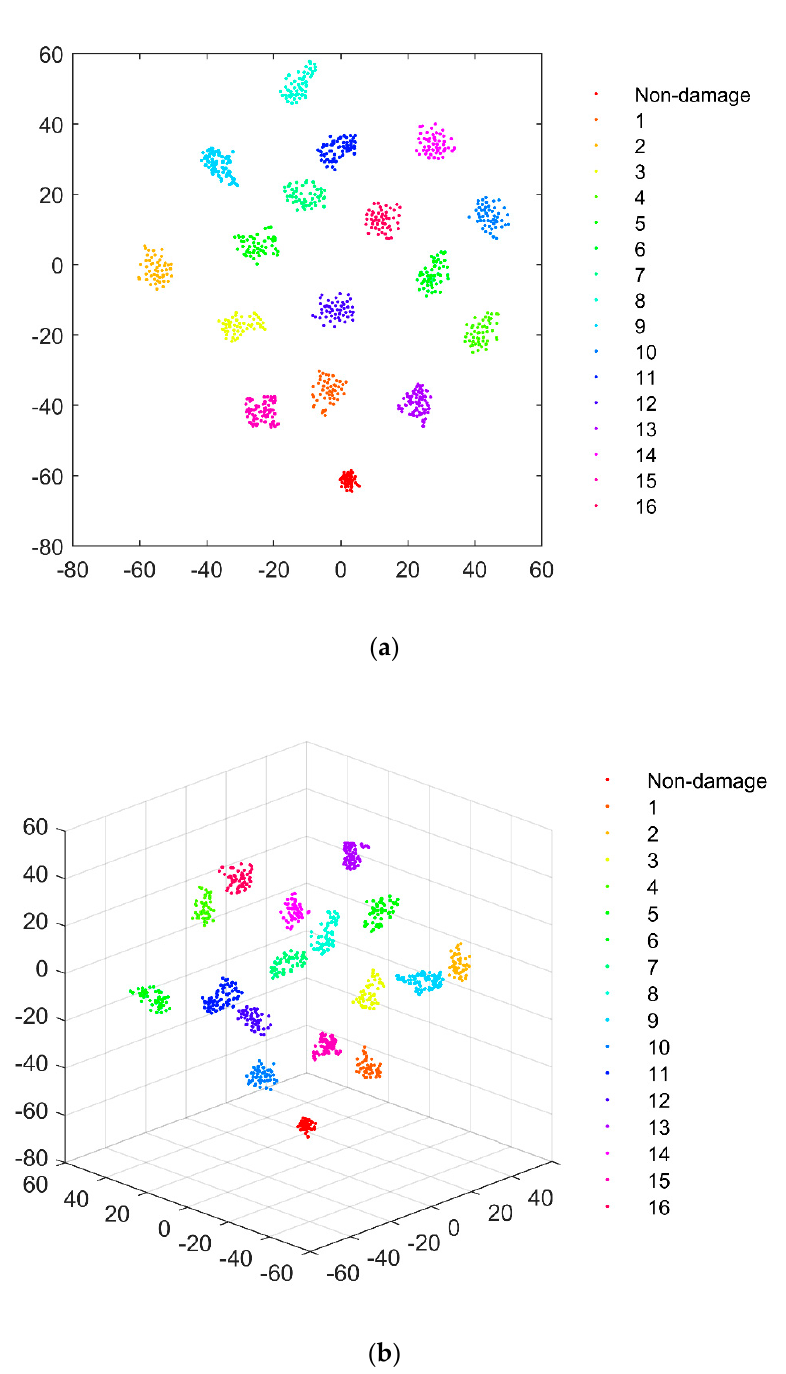
Figure 10. Visualization results of the damage features in the TF signals extracted by the 1D CNN model: ( a ) two- and ( b ) three- dimensional maps (different damage scenarios are labeled in the figure from 1 to 16).